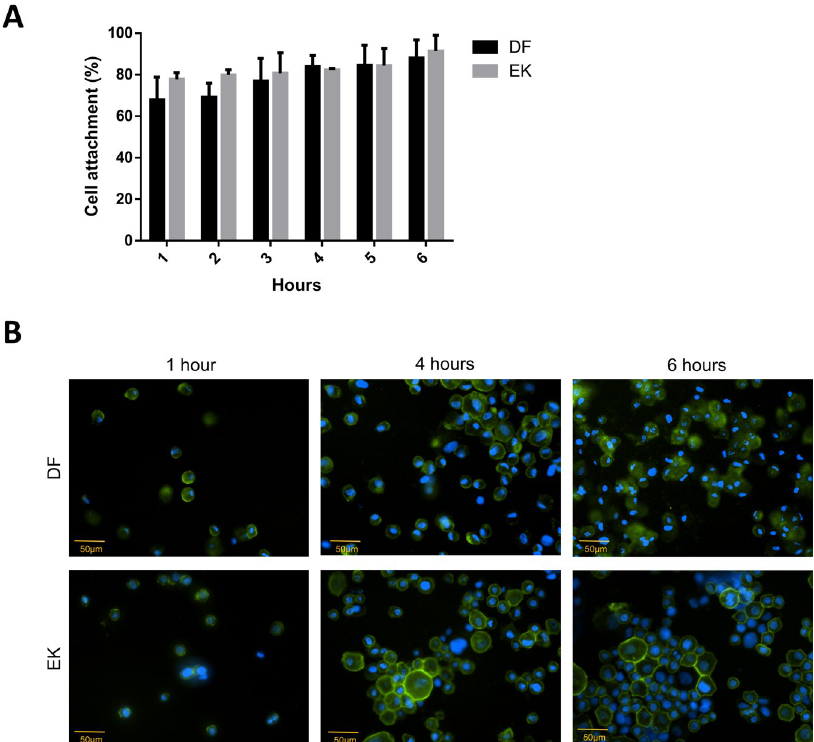
Figure 1. Cell attachment studies. ( A ) Percentage of dermal fibroblasts (DF) and epidermal keratinocytes (EK) attached on the hydrogel at 1 to 6 hours. No significant difference was observed between the 2 cell types (p > 0.05) ( B ) Phalloidin and DAPI staining for DF and EK at 1, 4 and 6 hours under 200 ×